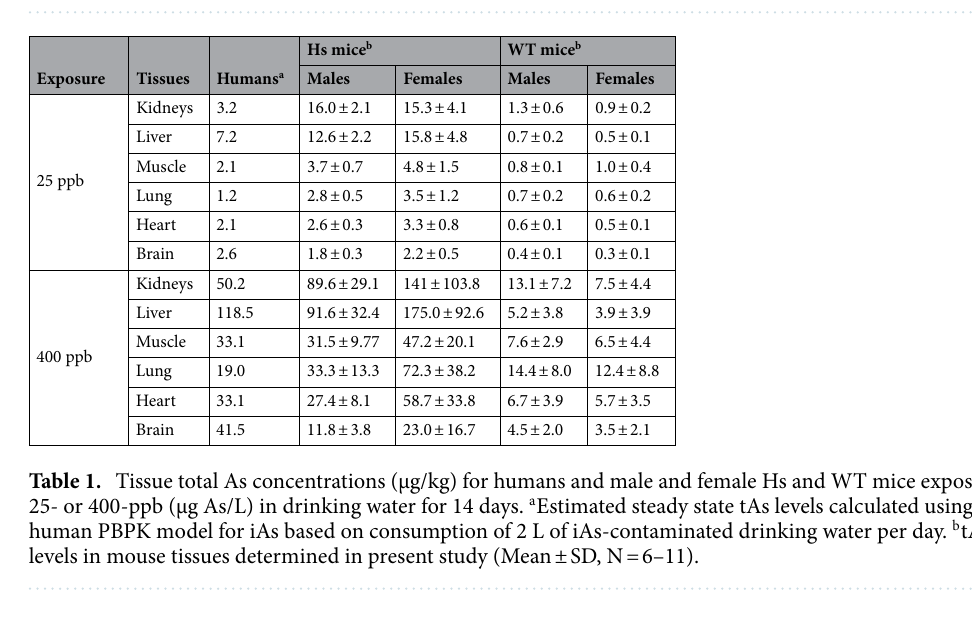
Figure 8. Percentages of total arsenic represented by inorganic arsenic (iAs), methylarsenic (MAs), and dimethylarsenic (DMAs) in lung, heart and pancreas of humanized (Hs) and wild-type (WT) male (M) and female (F) mice after 4-week exposure to 25-ppb or 400-ppb of inorganic arsenic in drinking water: The tissues of Hs mice with highest percentages of DMAs and the corresponding tissues of WT mice are shown. Each bar and whisker represent mean and SEM value, respectively. For 25-ppb exposure, N = 6 for Hs males and WT males, and N = 8 for Hs females and WT females. For 400-ppb exposure, N = 7 and 8 for Hs males and WT males, respectively, and N = 10 and 11 for Hs females and WT females, respectively. For each arsenic species, values marked with different letters are significantly different (p < 0.05).